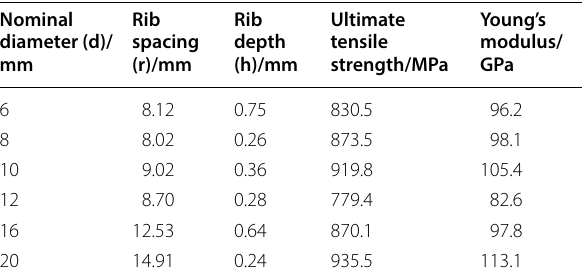
Fig. 3 Schematic drawing of specimen